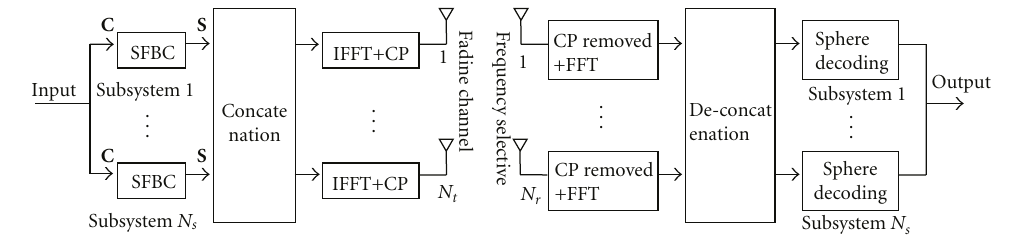
Figure 1: SFBC block diagram for a MIMO-OFDM